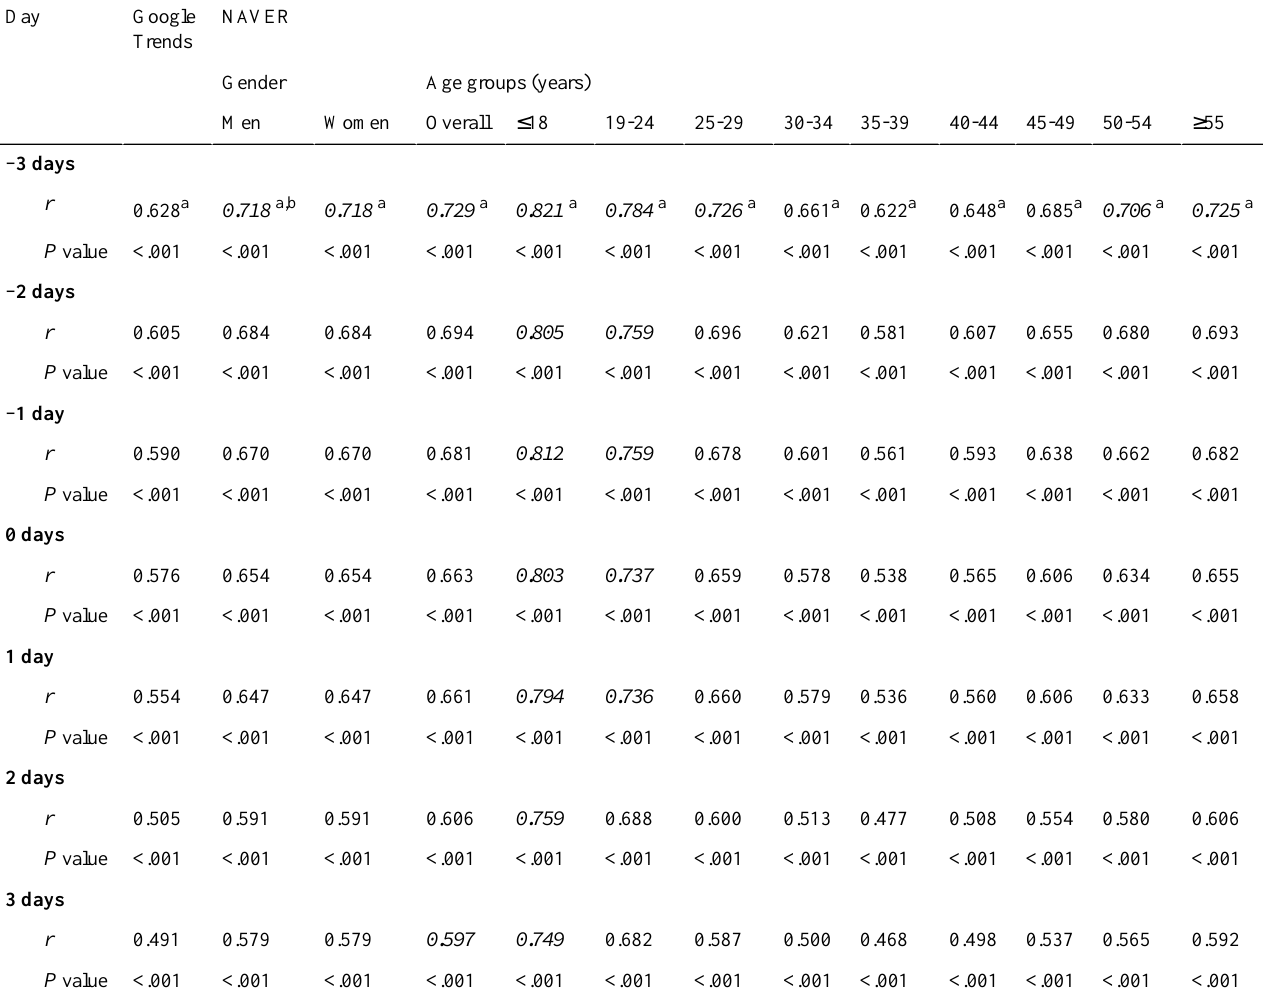
Table 1. Time-lag correlation coefficients between new COVID-19 cases, Google Trends, and NAVER relative search volumes related to the coronavirus in South